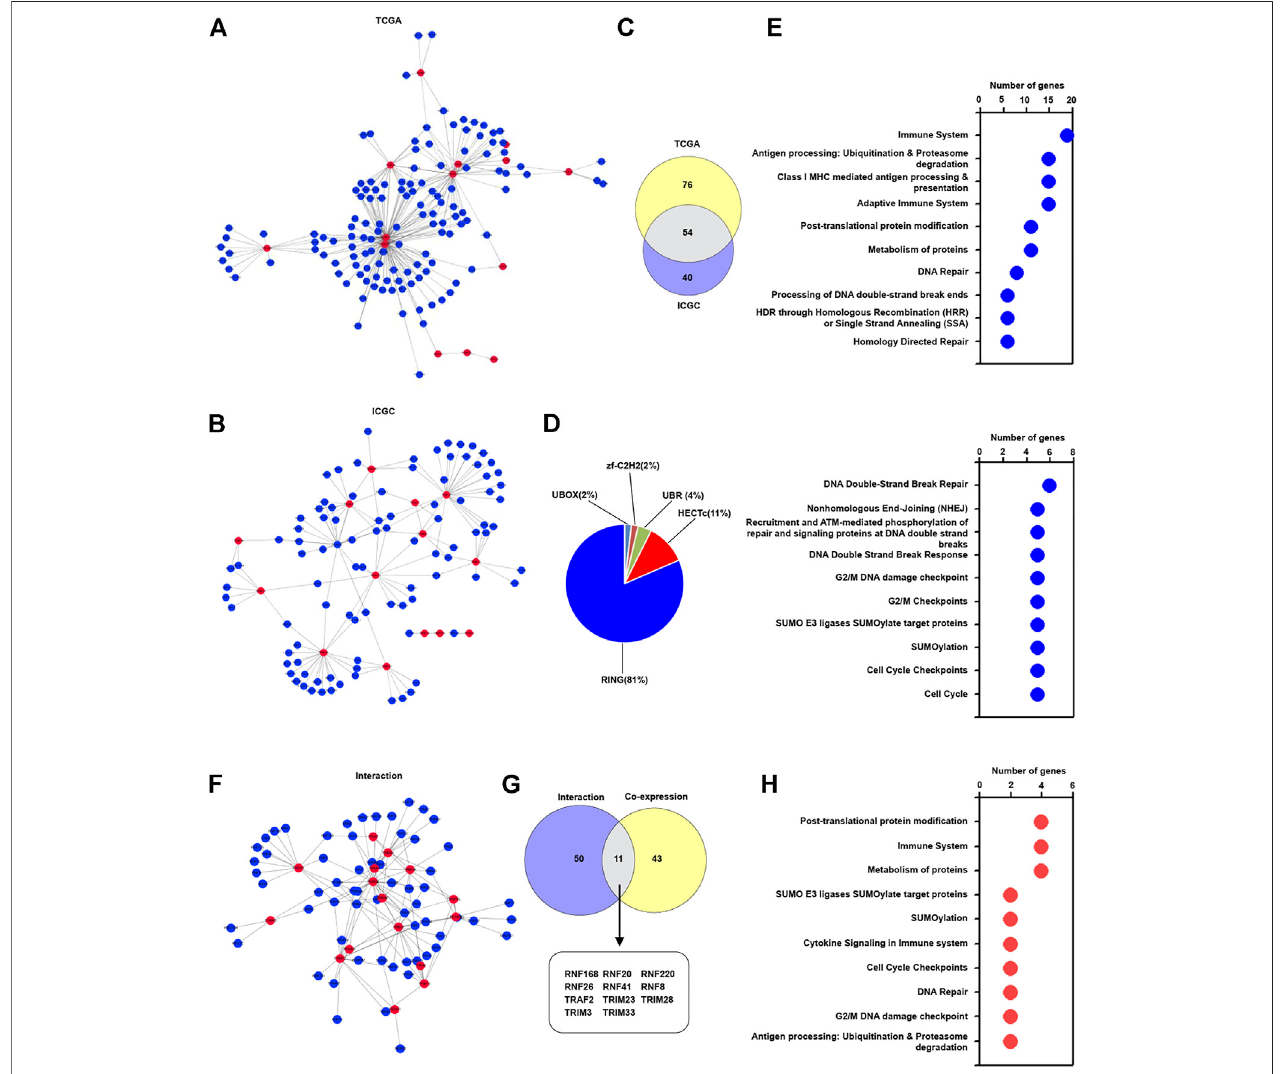
FIGURE 2 | The correlation of TRIM genes with other E3 ligases in HBV-positive HCC. (A) The co-expression pattern of 17 TRIMs with other E3 ligases in HBV- associated HCC in TCGA cohort. (B) The co-expression pattern of 17 TRIM genes with other E3 ligases in HBV-associated HCC in TCGA and ICGC cohort. (C) The common co-expressed E3 ligases without 17 identi fi ed TRIMs in HBV-positive HCC in the ICGC cohort. (D) The proportion of the E3 ligases with different domains. (E) ThetermsofReactomepathwayanalysisrelatedtothecommonE3ligases. (F) Theinteractionof17TRIMswithidenti fi edotherE3ligases. (G) Thecommongenes between the co-expressed and interacted E3 ligases. (H) Reactome pathway analysis related to the common E3 ligases.